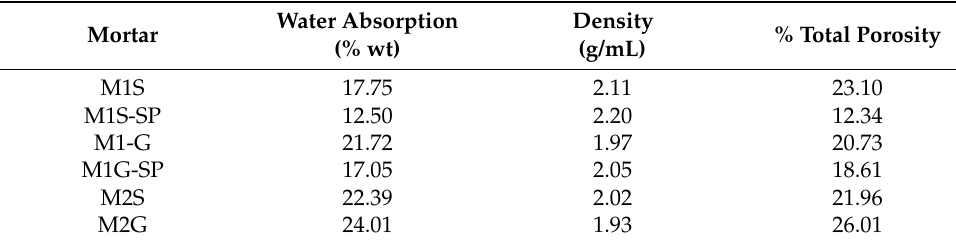
Table 7. Physical properties of 2 days mortars.